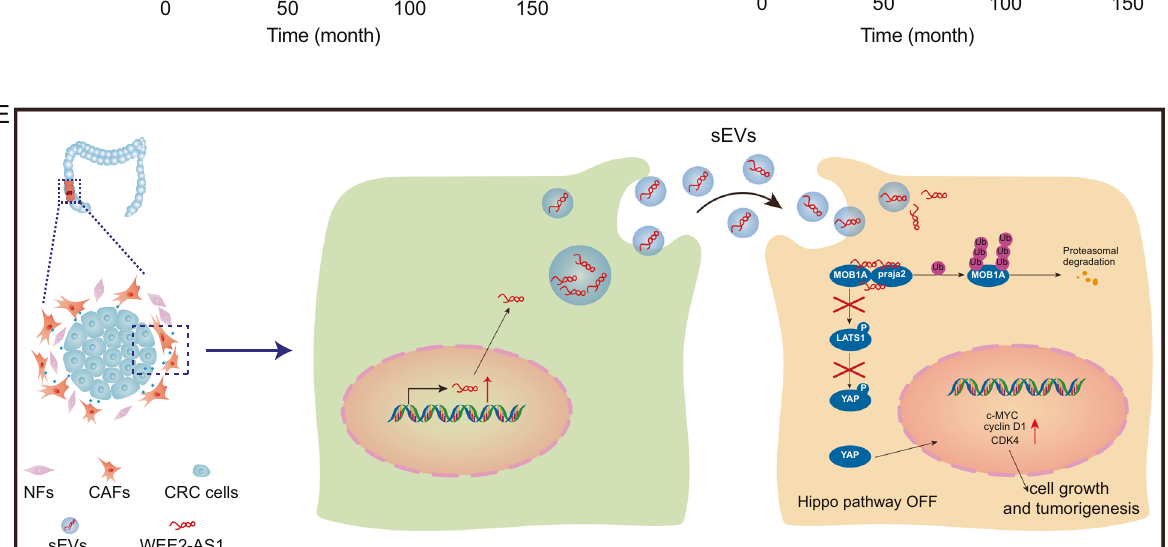
Cell Death and Disease (2022)